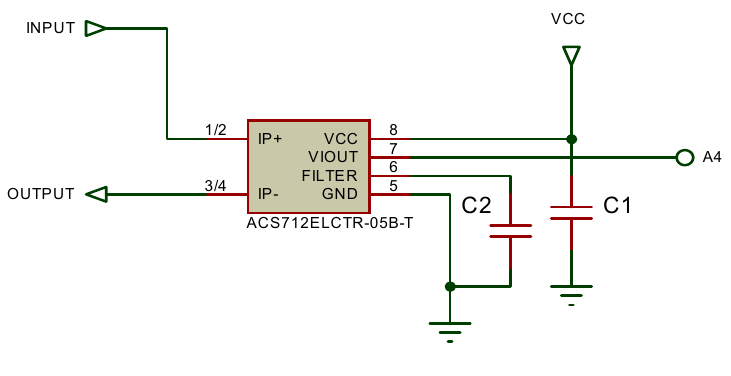
Figure 3. Current sensor circuit.